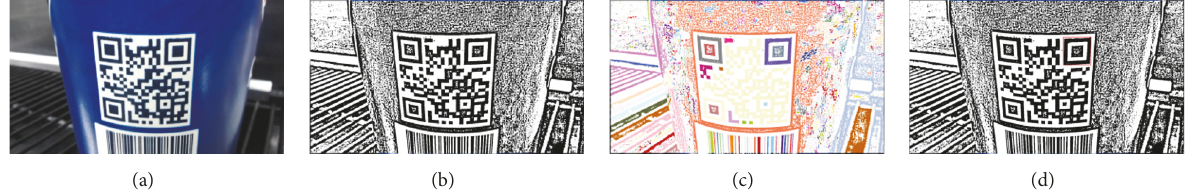
Figure3:Partialresultsofappliedalgorithmofstep1:(a)originalimage;(b)binarizationwithadaptivethresholding;(c)generationofcolored BLOBs; (d) filtered square BLOB highlighted by red